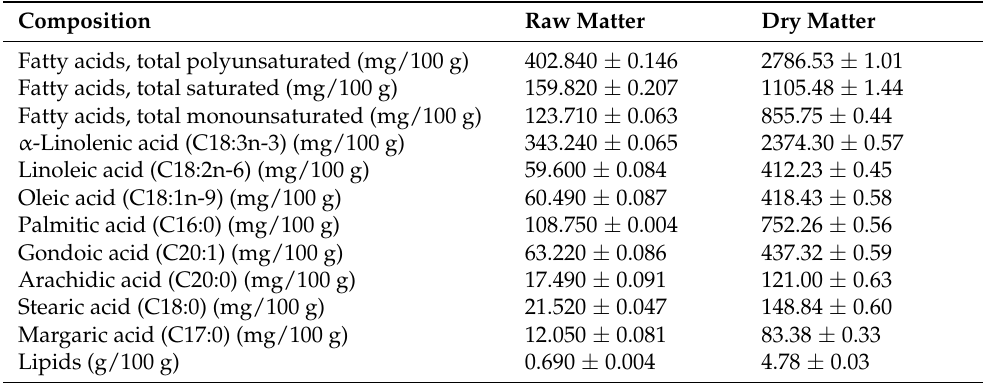
Table 2. Lipid and fatty acids composition of Crepis vesicaria subsp. taraxacifolia leaves (mean ± SD; n =